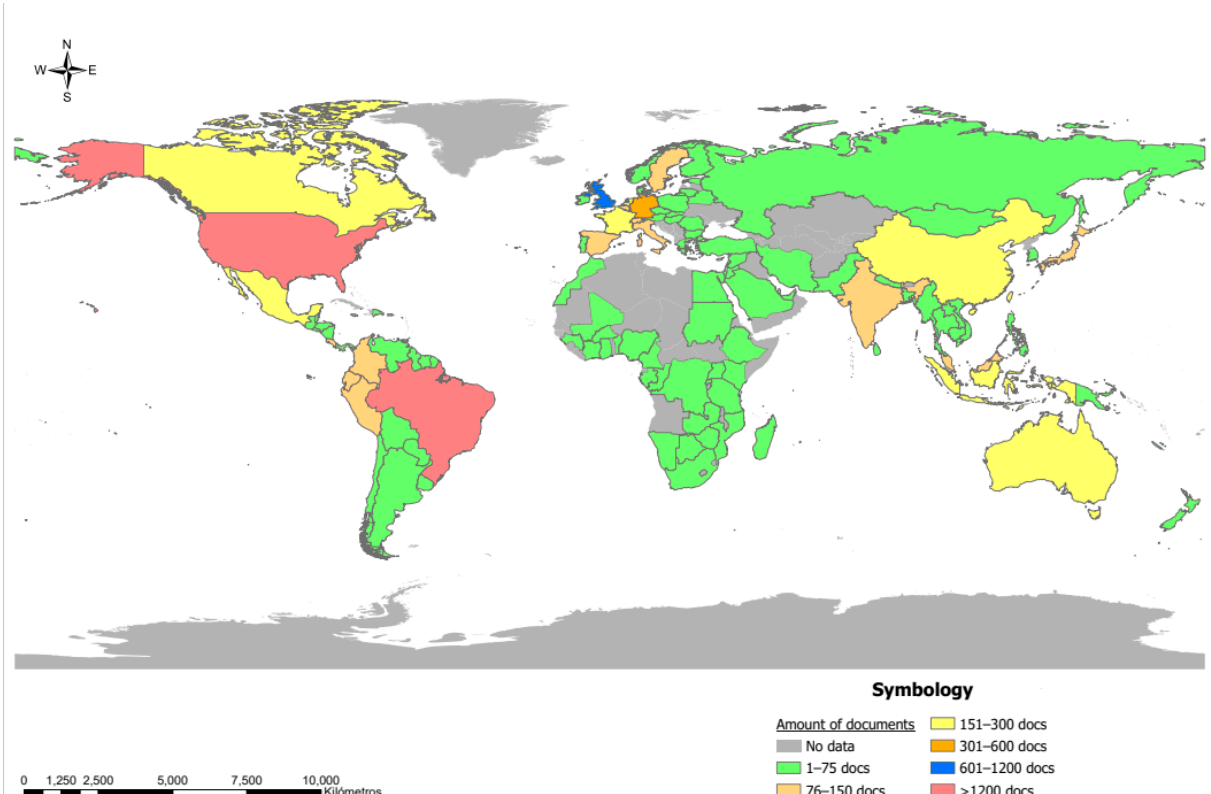
Figure 3. World map showing number of studies about LULC in tropical forest per country.